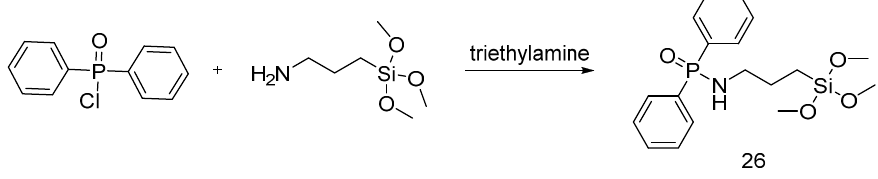
Figure 18. Synthesis of hybrid organic-inorganic flame retardant ( 26 ).